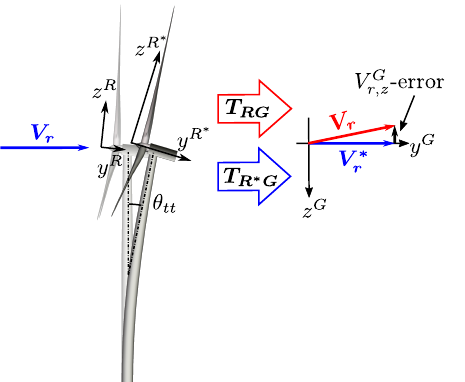
Figure 12. When the blades are horizontal, a small part of V rot ∗ is measured in the − z R ∗ direction on the right-hand side of the rotor and in the + z R ∗ direction on the left-hand side due to the gravity-induced deflection of the blade section. Furthermore, the blade moves faster in the upper part of the rotor due to the transition from backward to forward deflection and slower in the lower part. In the current method, however, the rotational speed, V rot , is assumed to be tangential and uniform. The mismatch results in a spurious side wind, seen as a mean offset in the x component of Fig. 10.